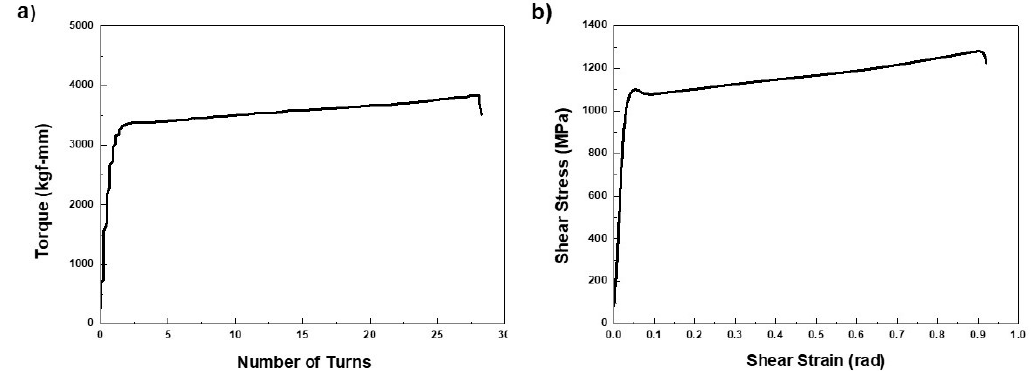
Figure 1. Torsional properties of cold drawn steel wires with a strain of 1.95. ( a ) Torque—NT curve and ( b ) shear stress—shear strain curve.